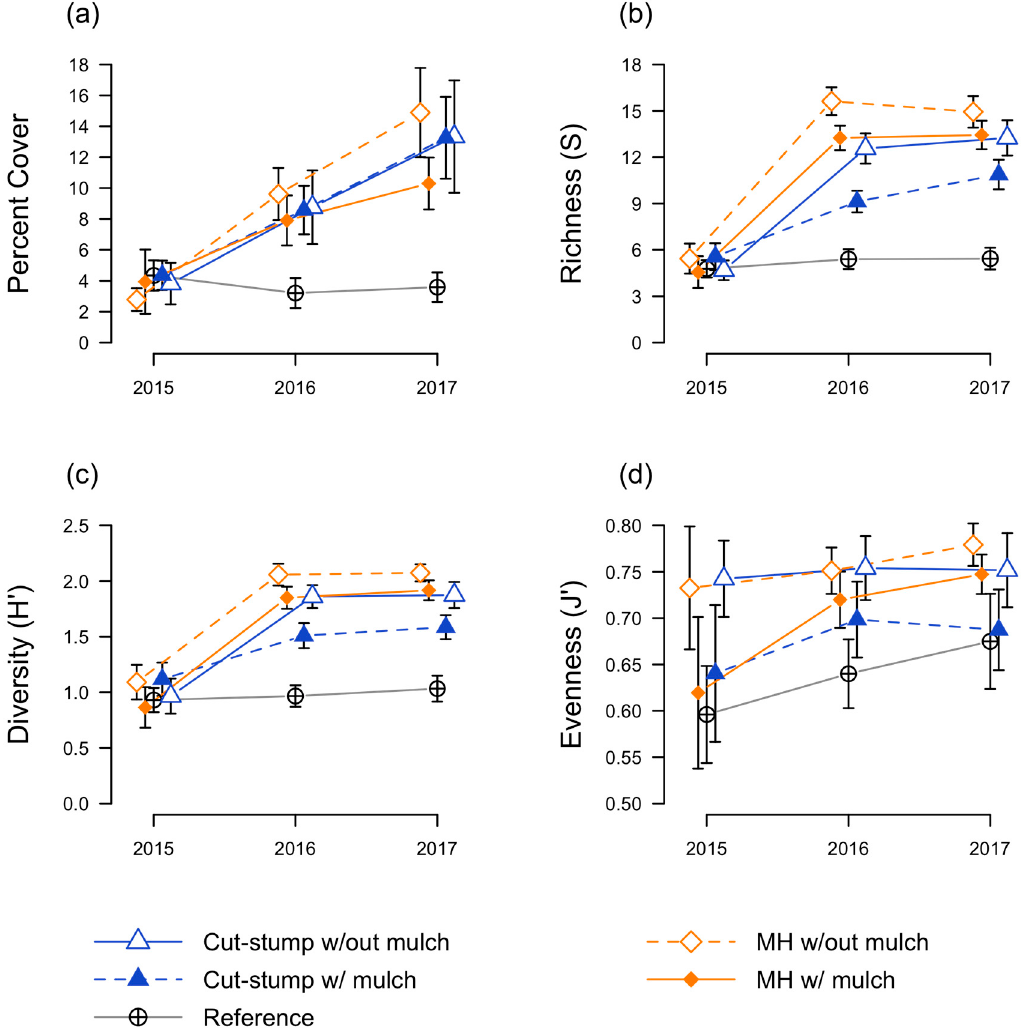
Figure 6. Percent cover ( a ) and diversity indices ( b – d ) of understory herbaceous plant species prior to invasive shrub removal (2015) and following shrub removal (2016–2017) accomplished using cut-stump or forestry mulching head (“MH”) treatments, with mulch removed/absent or added/present. Invasive shrubs were not removed in reference areas for comparison. Dashed lines indicate management techniques with mulch manipulated (added/removed) and solid lines represent operational (no mulch manipulation) management techniques. Values are means ± standard error. Data were collected from mid-July to late August at four mature secondary hardwood forest sites near West Lafayette, IN, USA.